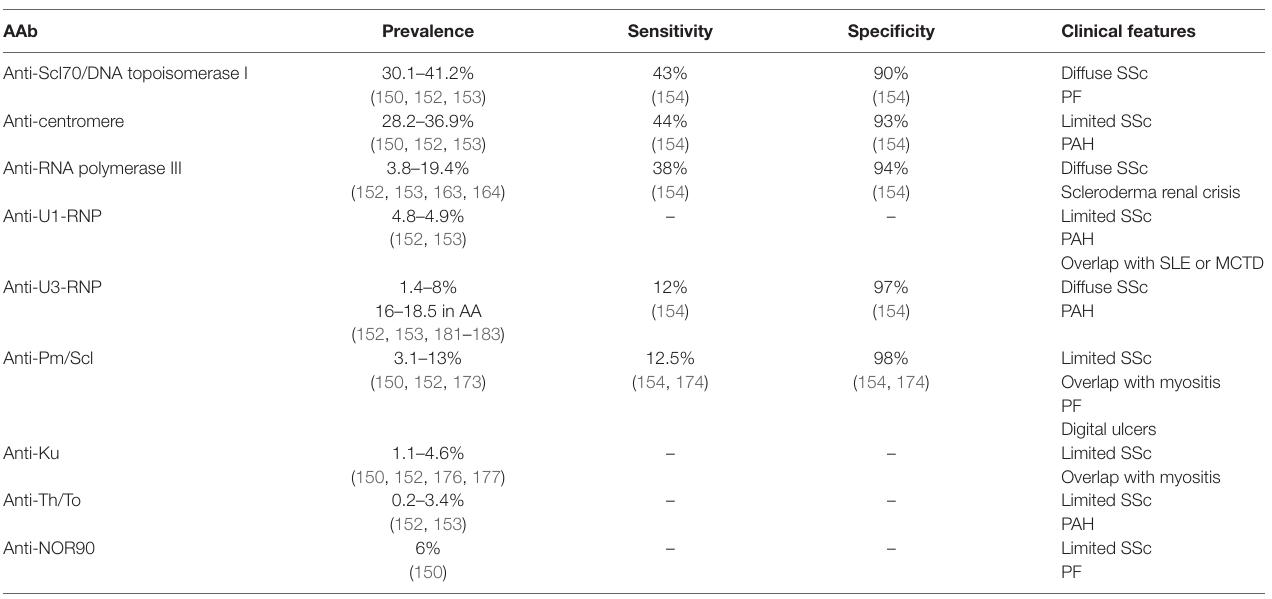
TAble 4 | AAb associated with systemic sclerosis (SSc). AAb Prevalence Sensitivity